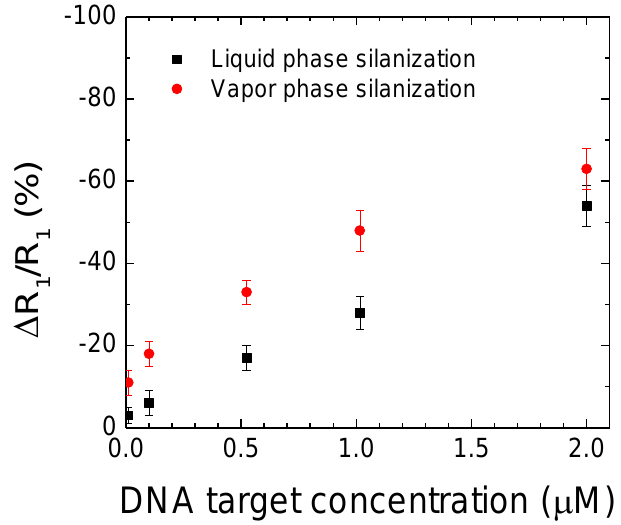
Figure 6. Evolution of the polarization resistance ∆R 1 /R 1 of the biomodified SnO 2 nanoporous films as a function of target DNA concentration in the case of vapour (red) and liquid phase silanization